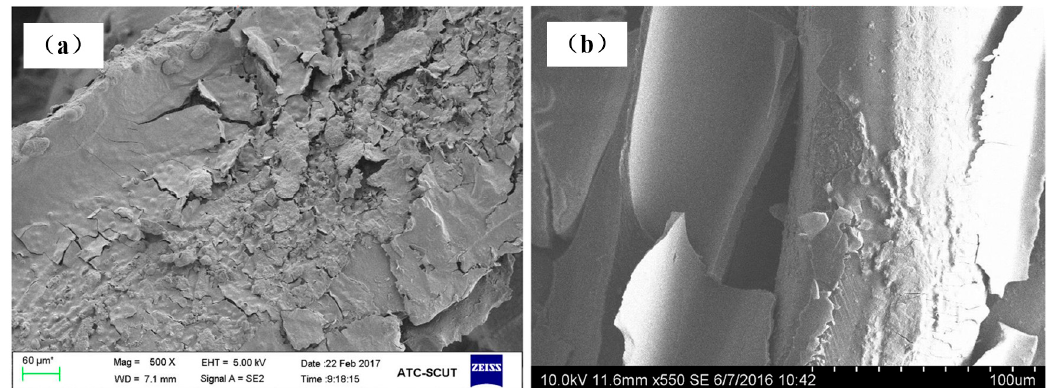
Figure 9. SEM of samples for the ninth thermal shock test: ( a ) made of cutting fibers; ( b ) made of commercial drawing fibers.